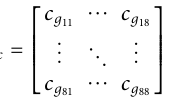
the cyan panel. According to the LUT of the cyan panel, the driving voltage matrix V c can be calculated by Formula 9. And driving voltage matrixes of the other two color panels can also be calculated in this way.